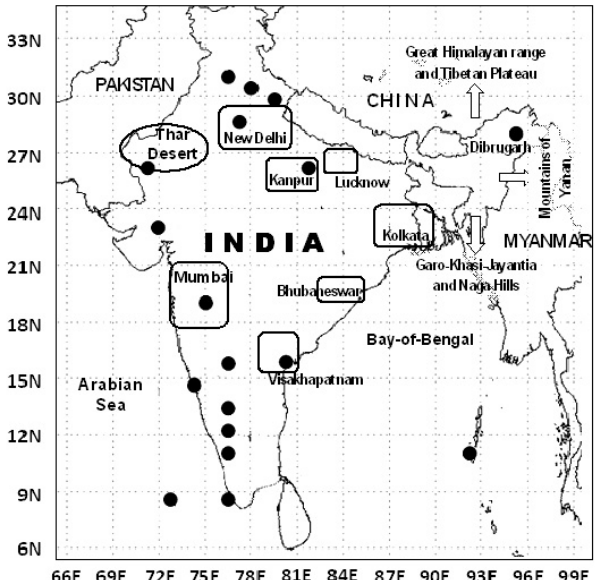
Fig. 1. Ground-based MWR observatories (black dots) over the In- dian mainland and the prominent Industrial regions (squares) along the Ganga basin, western India and the peninsular region of the Bay- of-Bengal. The ellipse represents the Thar Desert